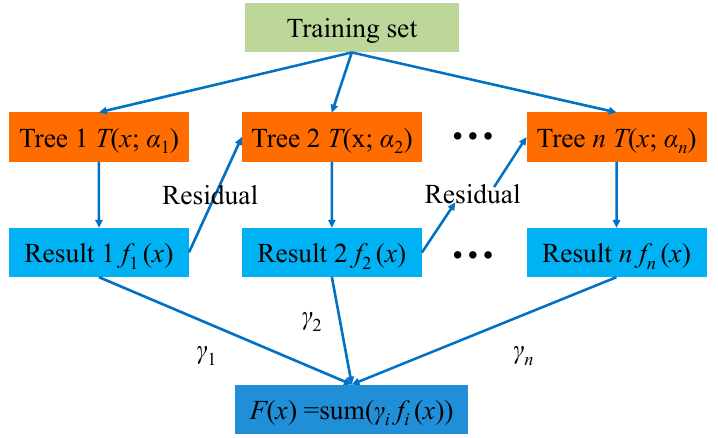
Figure 3. Diagram of GBDT algorithm.